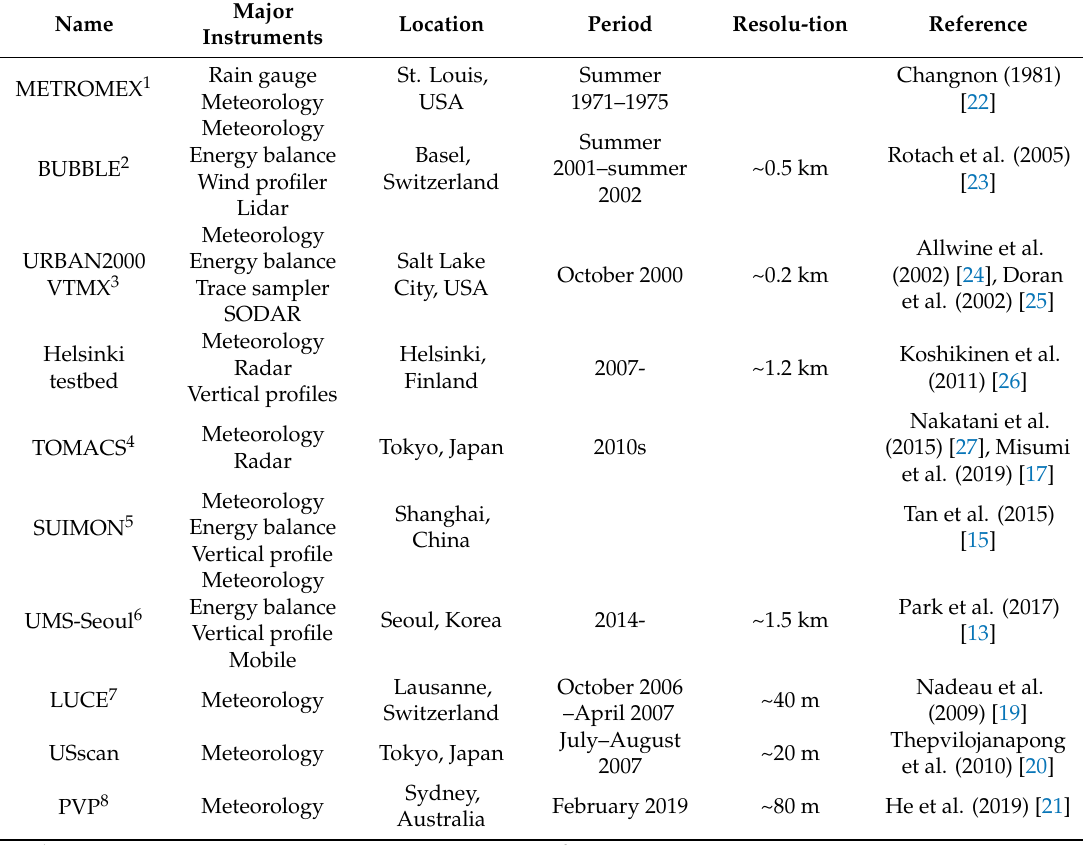
Table 1. Summary of urban meteorological observation